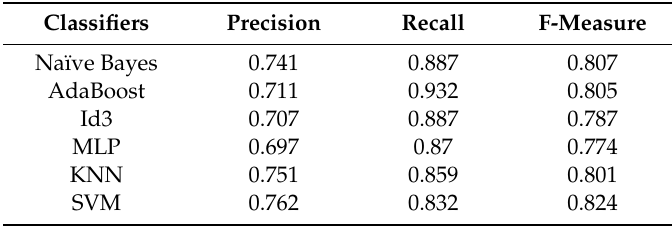
Table 1. Results of the classifiers of research conducted by Farzaneh, Z. (2019) (MLP =